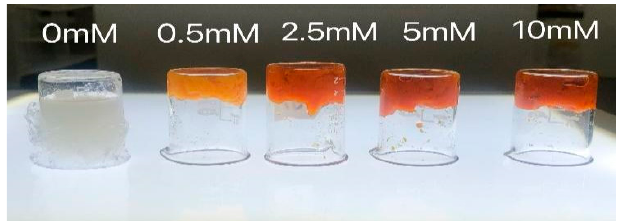
Figure 1. Morphology observation of duck myofibrillar proteins gels treated with different malondialdehyde concentrations (0, 0.5, 2.5, 5.0, and 10.0 mmol/L).